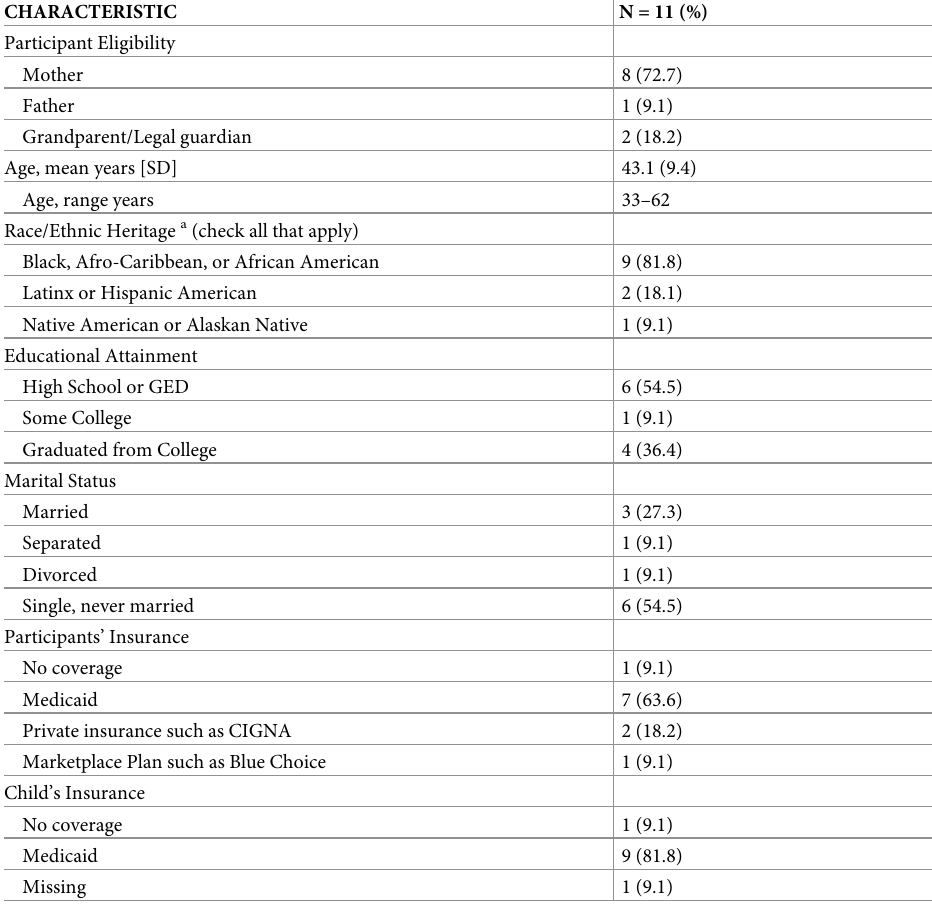
Table 1. Participant